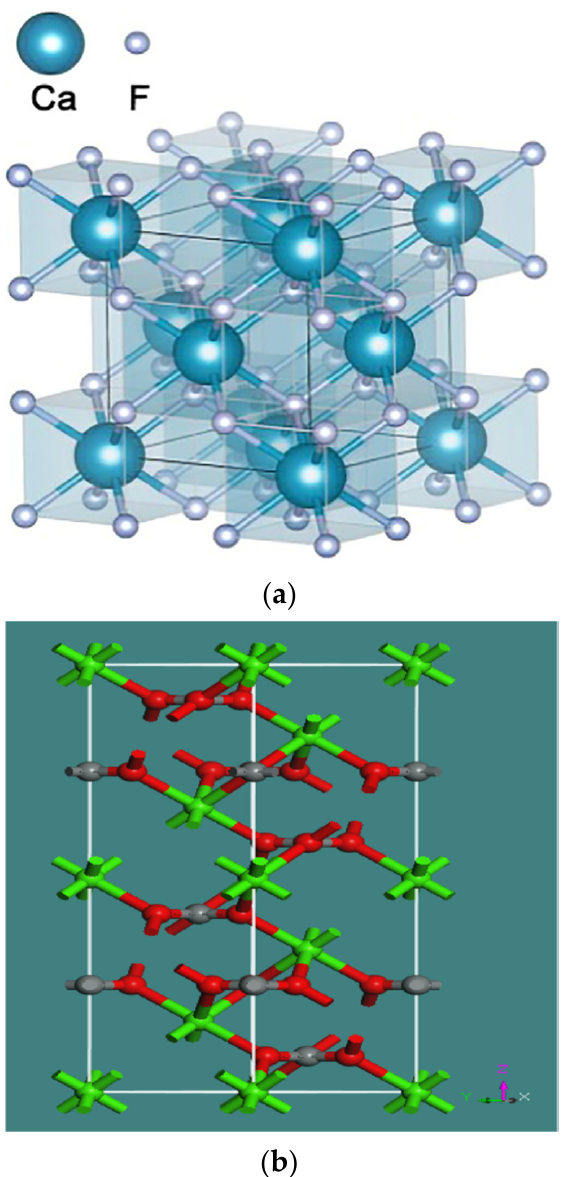
Figure 1. Unit cell structure of ( a ) fluorite [21] and ( b ) calcite (Ca = light green, O = red, C = grey) [22].